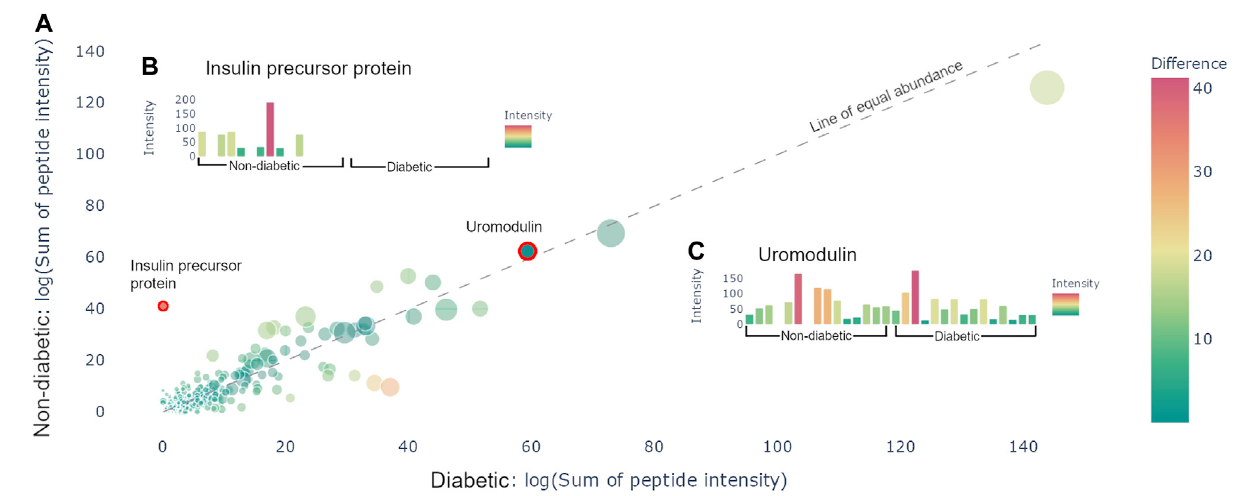
FIGURE2| Proteinview. (A) Scatterplotcontainingalltheproteinspresentinthesamples.Thesizeofthedotscorrespondstothenumberofpeptidesderivedfrom the precursor protein. The color corresponds to the distance from the line of equal abundance, i.e., the difference in abundance metric between the two groups. (B) Hovering over the insulin precursor protein results in the presented sample graph. Peptides are only present in non-diabetics. (C) Hovering over uromodulin generates the presented sample graphs. Uromodulin is varyingly present in both groups.